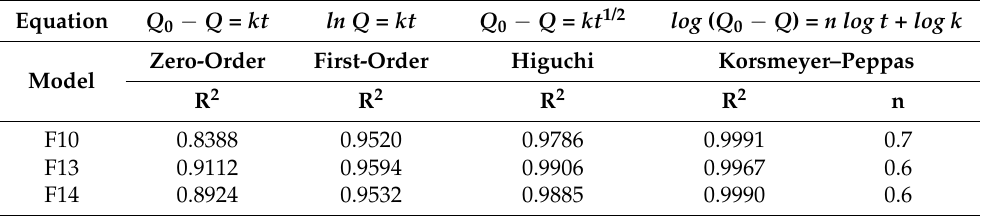
Table 7. Mathematical model fitting of release kinetics of moxifloxacin from F10, F13, and F14 formulations (mean ± SD, n = 3).